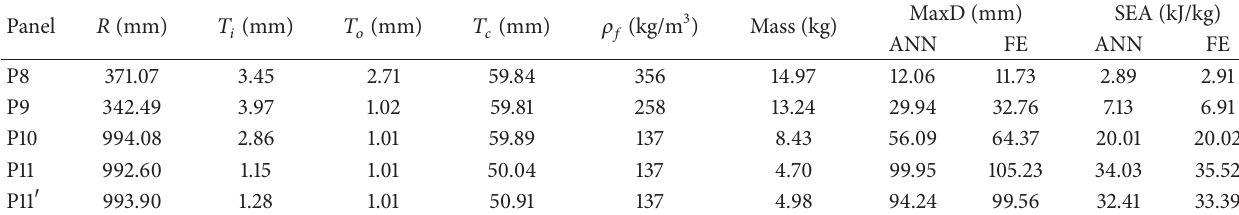
Table 7: Optimum panel designs for Case Study